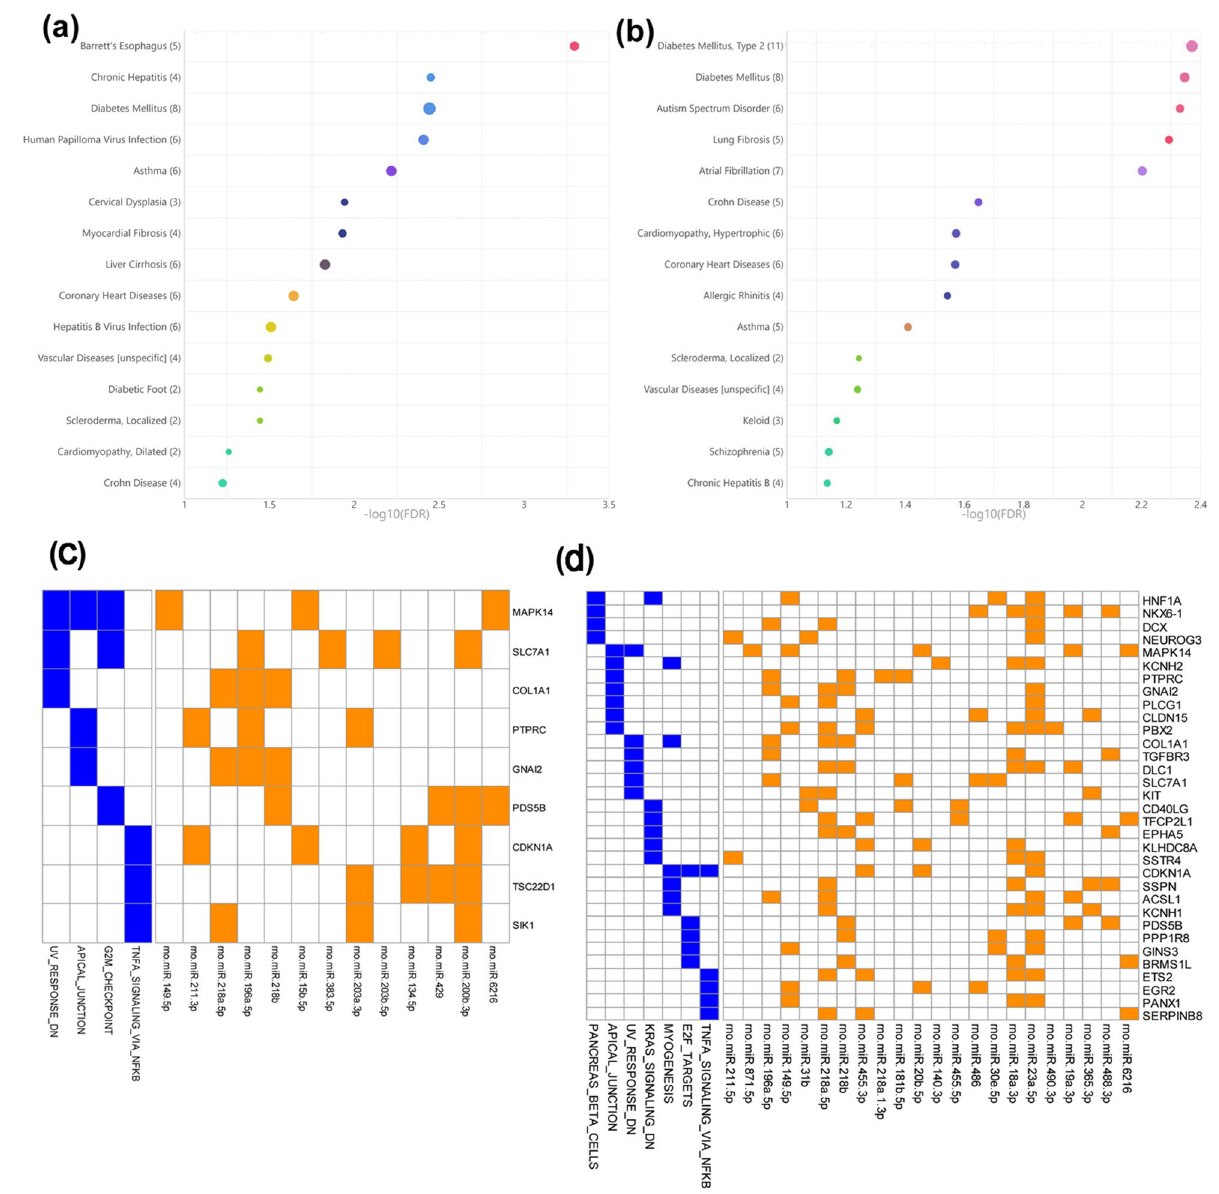
Figure 3. Functions and disease association of the deregulated circulating miRNAs of SHR-vs-WKY comparisons in arterial and venous blood. ( a , b ) Disease association of deregulated venous miRNAs ( a ) and deregulated arterial miRNAs ( b ) in SHR-vs.-WKY comparisons. Bubbles are ranked by statistical significance (FDR), and the bubble size is proportional to the number of deregulated miRNAs associated with certain diseases. ( c , d ) Deregulated venous circulating miRNAs ( c ) and deregulated arterial circulating miRNAs ( d ) in SHR-vs-WKY comparisons. Interactions of miRNAs and target genes are indicated by orange boxes, and the presence of target genes in pathways is indicated by blue